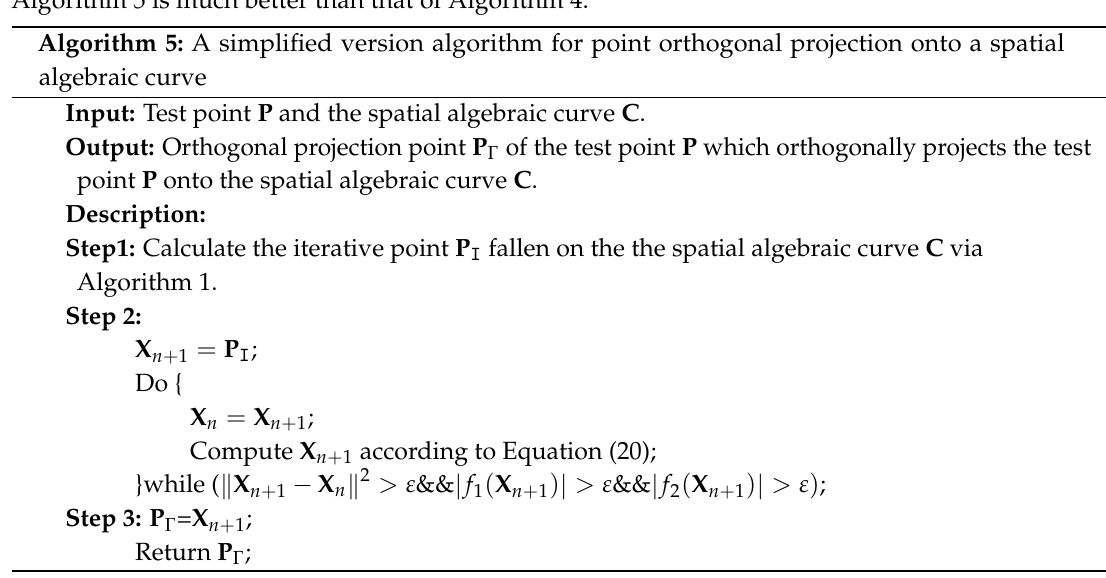
Algorithm 5: A simplified version algorithm for point orthogonal projection onto a spatial algebraic